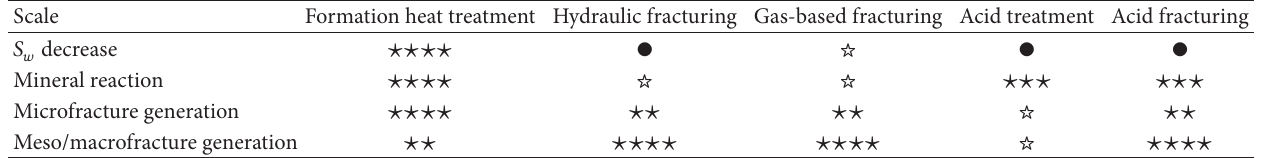
Table 4: Contribution of various stimulation methods on different scales of mass transfer.